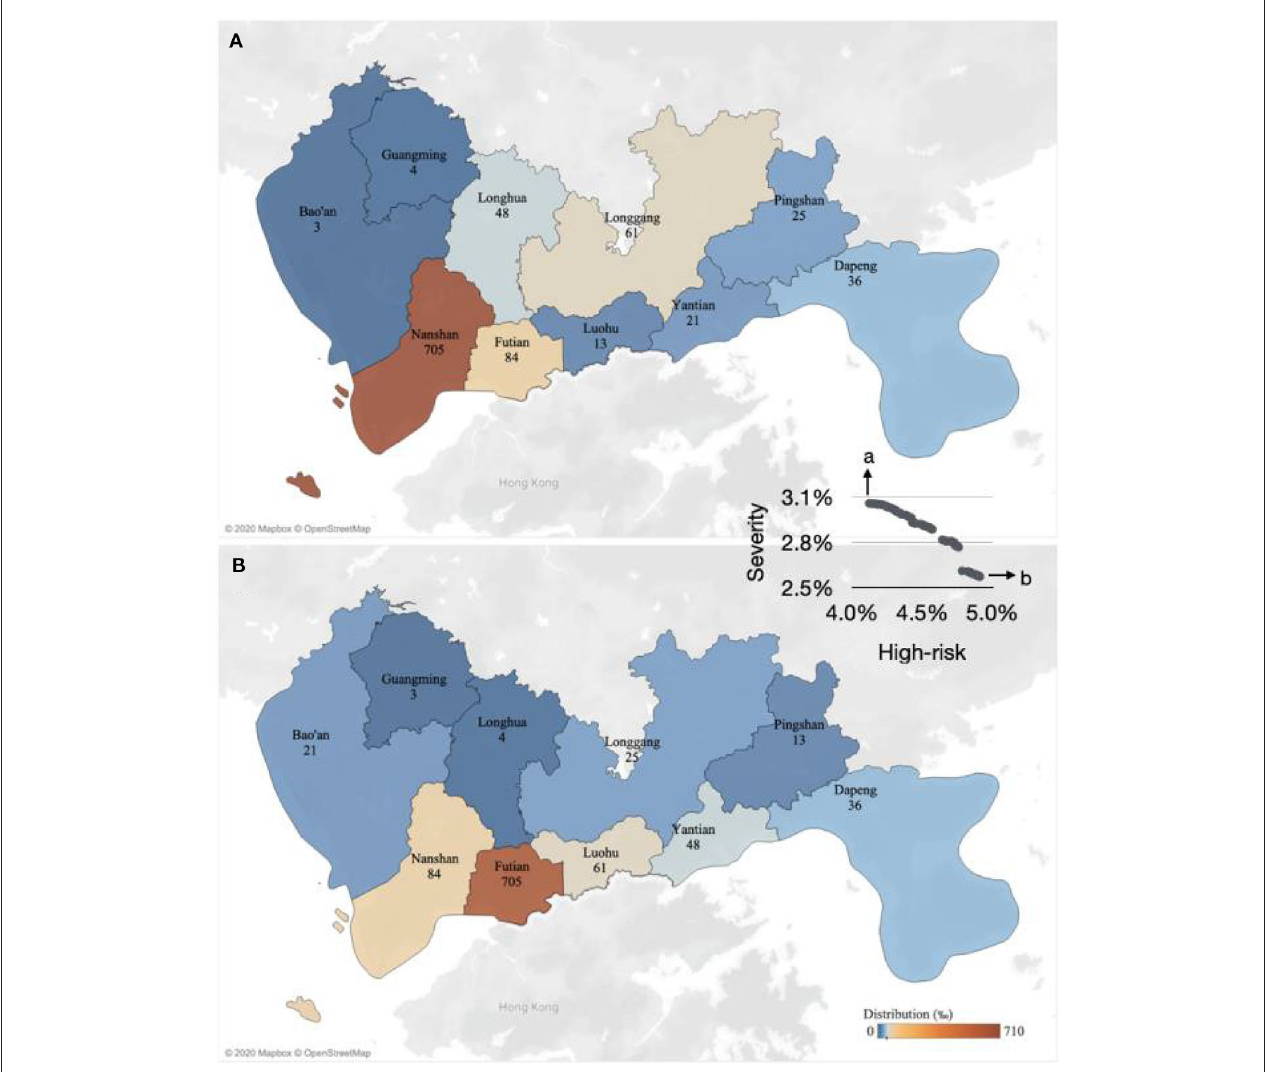
FIGURE 2 | Estimated PPE optimized allocation in the 10 districts of Shenzhen on February 14, 2020. The Pareto frontier uses the two objectives of high-risk and severity priorities in the middle right inset. The predicted allocation of the greatest high-risk priority in (A) and the predicted allocation of the greatest severity priority in (B)